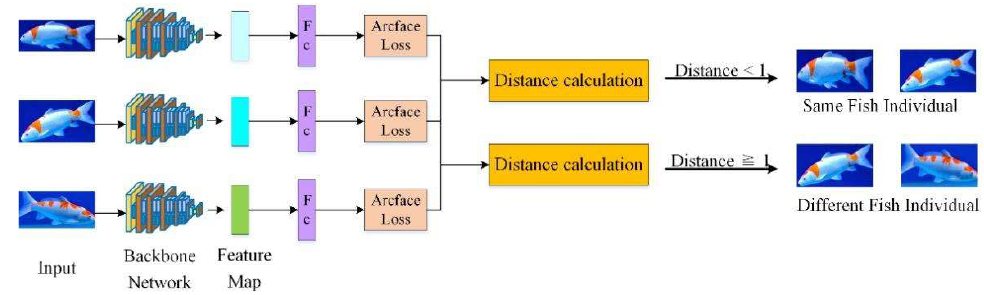
Figure 9. Schematic diagram of the network structure of the individual fish recognition module.